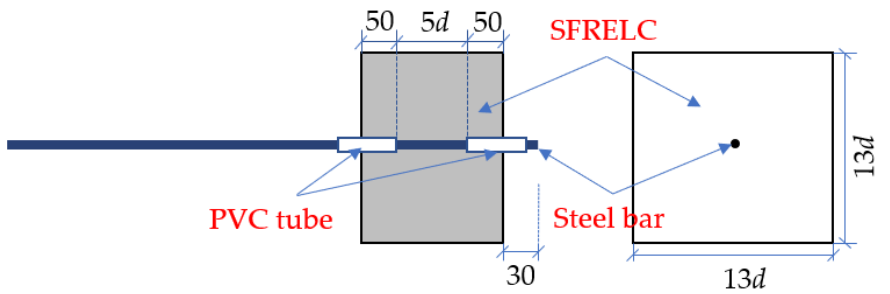
Figure 1. Specimen of bond-slip by using the direct pull-out test.